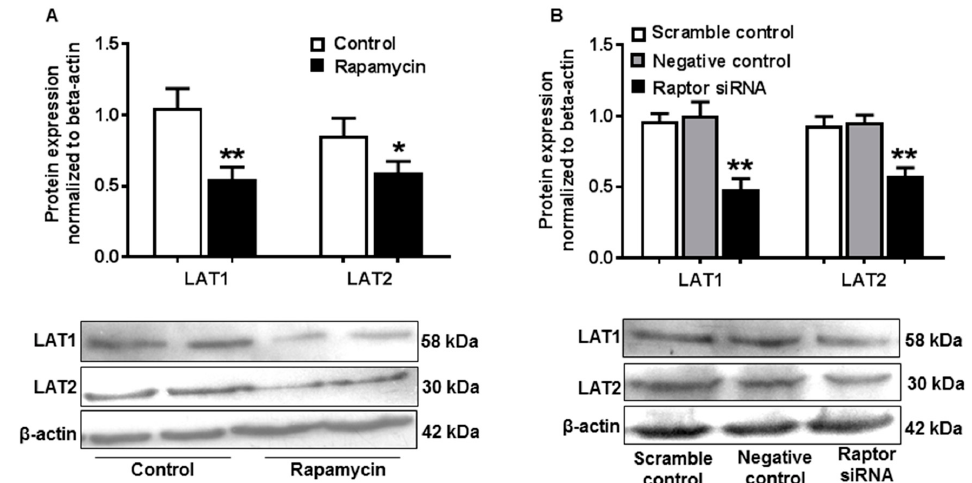
Figure 5. Inhibition of mTORC1 activity resulted in decreased amino acid transporter expression in JEG-3 trophoblast cells. ( A ) Protein expression of LAT1 and LAT2 assayed by Western blot in JEG-3 cells treated with or without rapamycin. The bar graphs show relative expression after being normalized with β -actin expression in each sample. Rapamycin induced a significant decrease in LAT1 and LAT2 expression. Data are from five independent experiments. * p < 0.05, ** p < 0.01, control versus rapamycin. ( B ) Expression of LAT1 and LAT2 detected by Western blot in JEG-3 cells treated with scrambled or negative or raptor siRNA. The bar graph shows data from five independent experiments. Raptor siRNA caused a significant reduction in LAT1 and LAT2 expression. ** p < 0.01, scrambled control or negative control versus raptor siRNA.